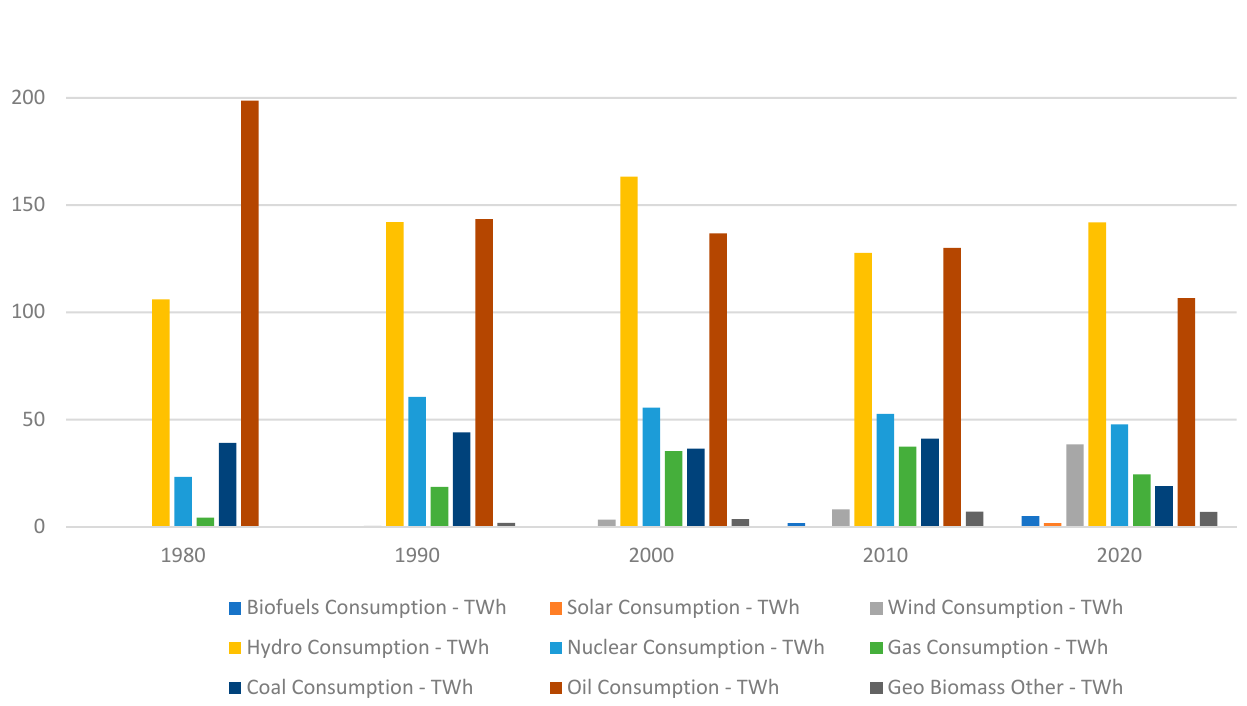
Figure 1. Average energy consumption by source in the Figure 1. Average e nergy consumption by source in the region.